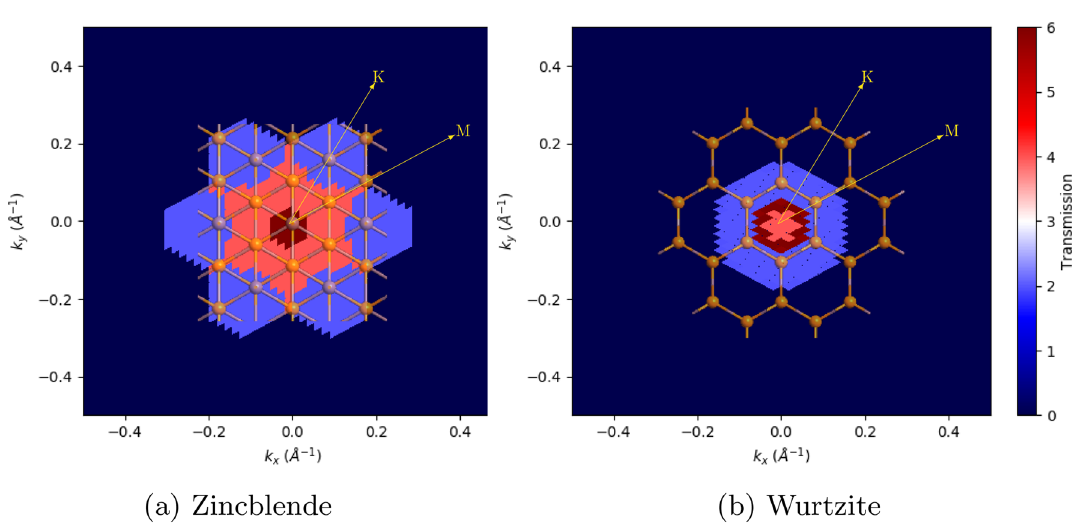
Figure 3. InP transmission coefficients at − 0.66 eV in reciprocal space, with the real space lattice overlaid for comparison of